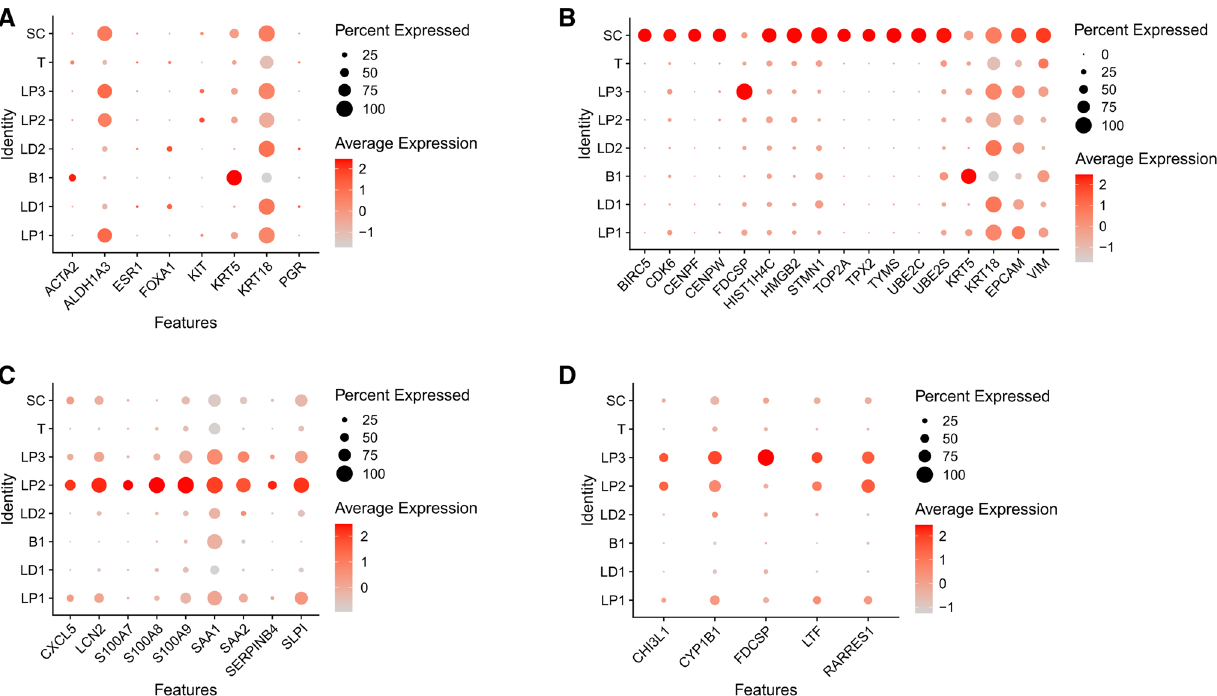
Fig. 2 Gene expression in human adult mammary cell populations. Dot plots show the expression of population specific genes in the cell populations at 0.14 cluster resolution. A Mammary luminal progenitor, luminal differentiated, and basal cell marker expression in human adult mammary cell populations. B SC gene expression in human mammary cells, as well as a basal (KRT5), luminal (KRT18), epithelial (EPCAM), and mesenchymal (VIM) marker expression. C LP2 and D LP3 marker gene expression in human mammary